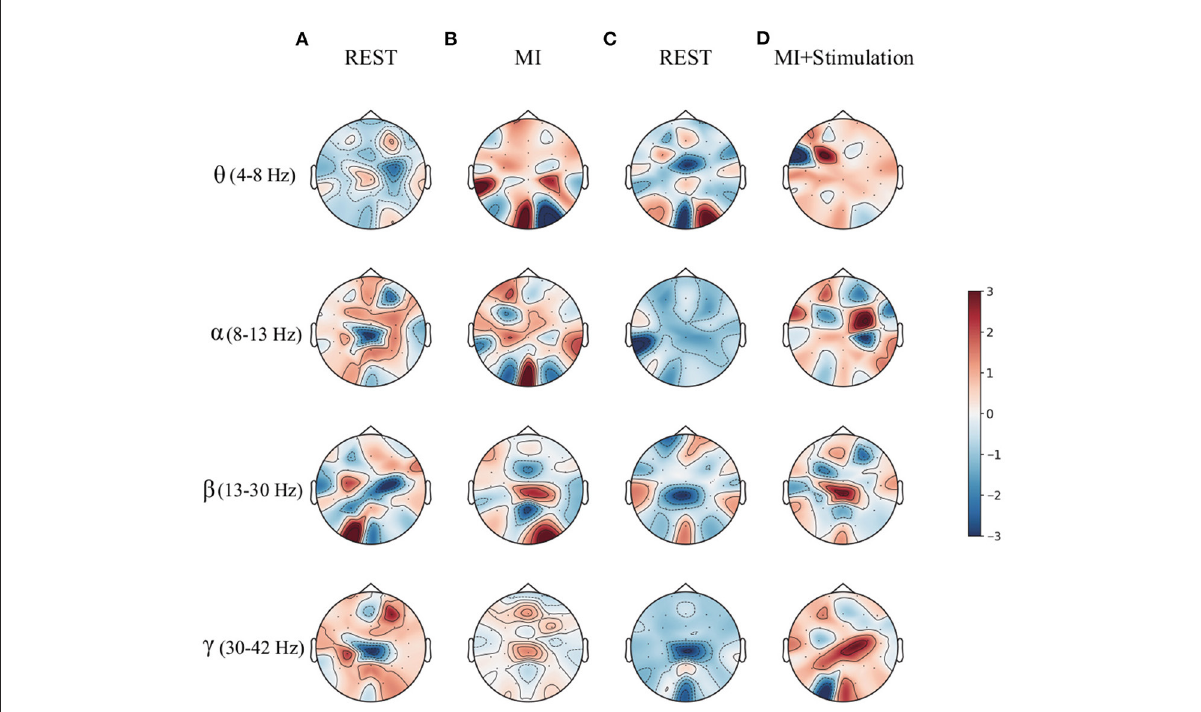
FIGURE6 The topographic map of the spatial filter for the lower limb movement imagery with and without stimulation from subject A09 of in-house dataset. (A) The rest state imagery without stimulation. (B) Lower limb movement imagery without stimulation. (C) The rest state imagery with stimulation. (D) Lower limb movement imagery with stimulation.